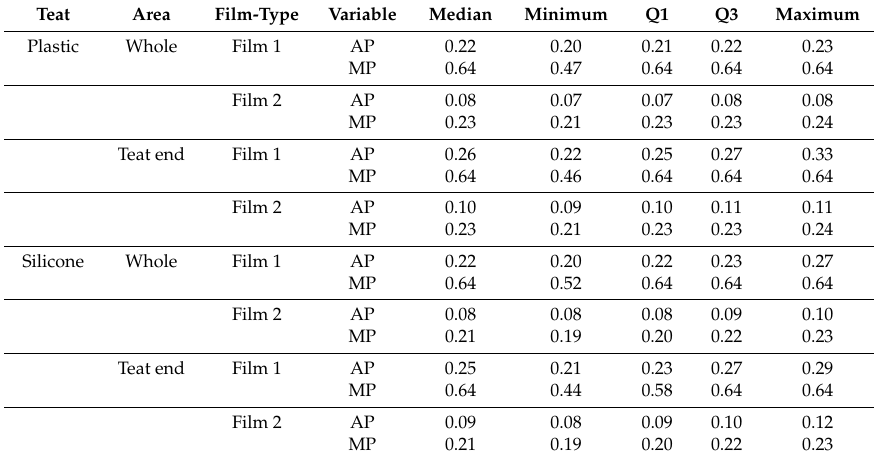
Table 1. Median, minimum, 25% quantile (Q1), 75% quantile (Q3), and maximum values of average pressure (AP) and maximum pressure (MP) of both teats, tested areas, and film types.